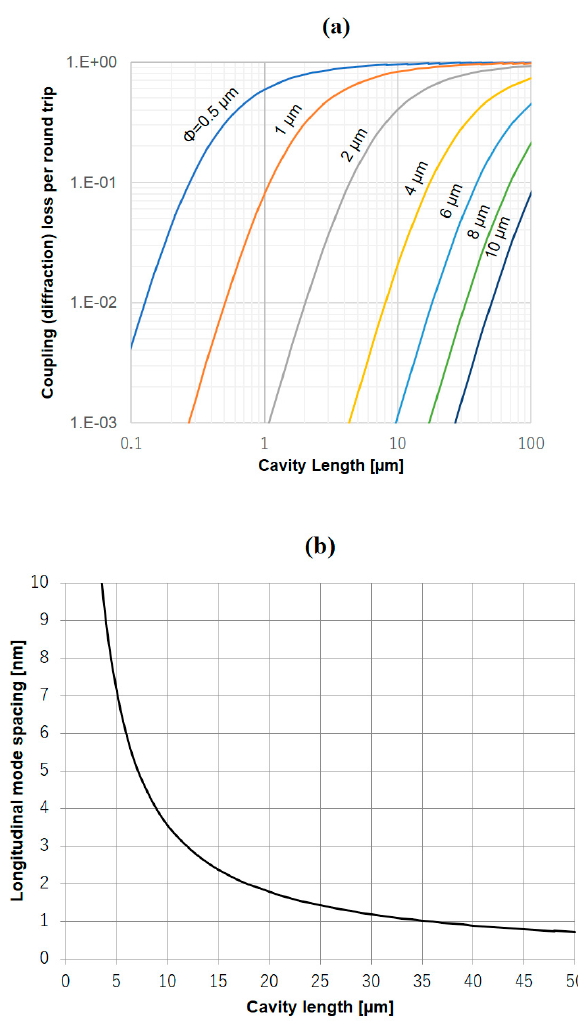
Figure 1. ( a ) Calculated coupling (diffraction) losses per round trip for beams having Gaussian lateral profiles with a beam waist from 1 to 10 μ m. ( b ) Longitudinal mode spacing calculated for the parameters n = 2.45, λ = 450 nm and dn/d λ = − 0.001.